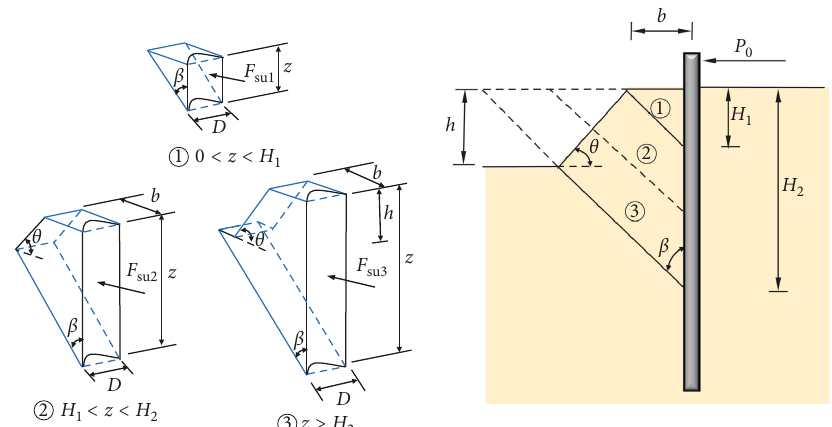
Figure 3: Wedge failure model for a laterally loaded pile near a